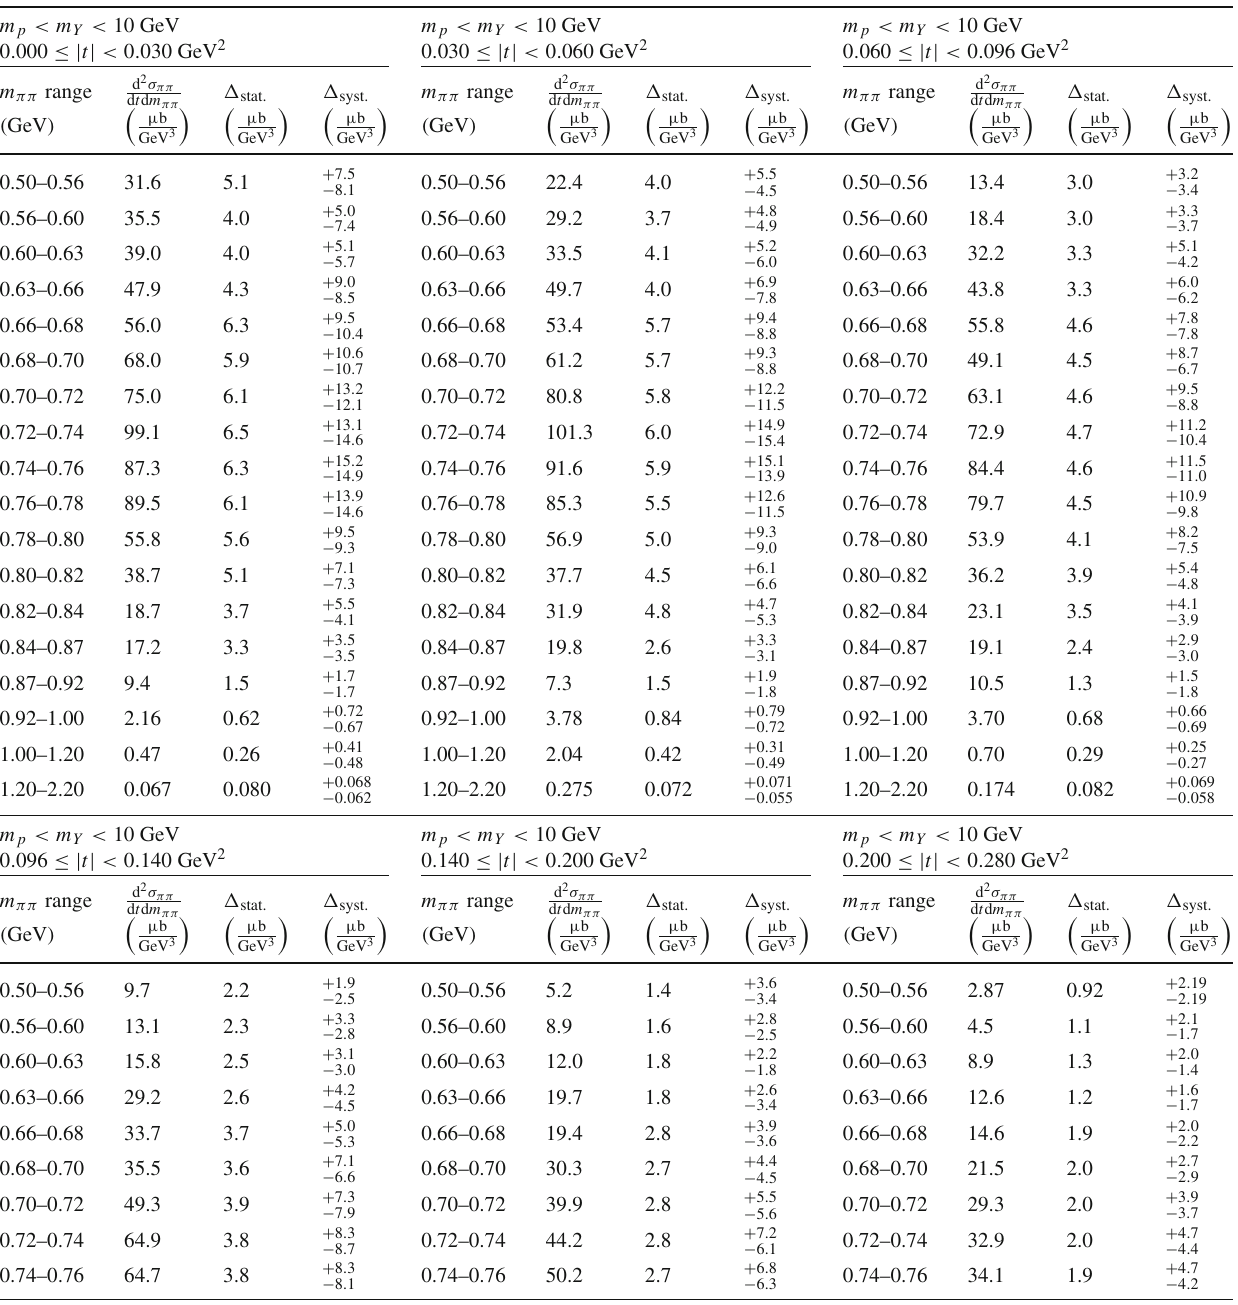
21 Unfolded proton-dissociative